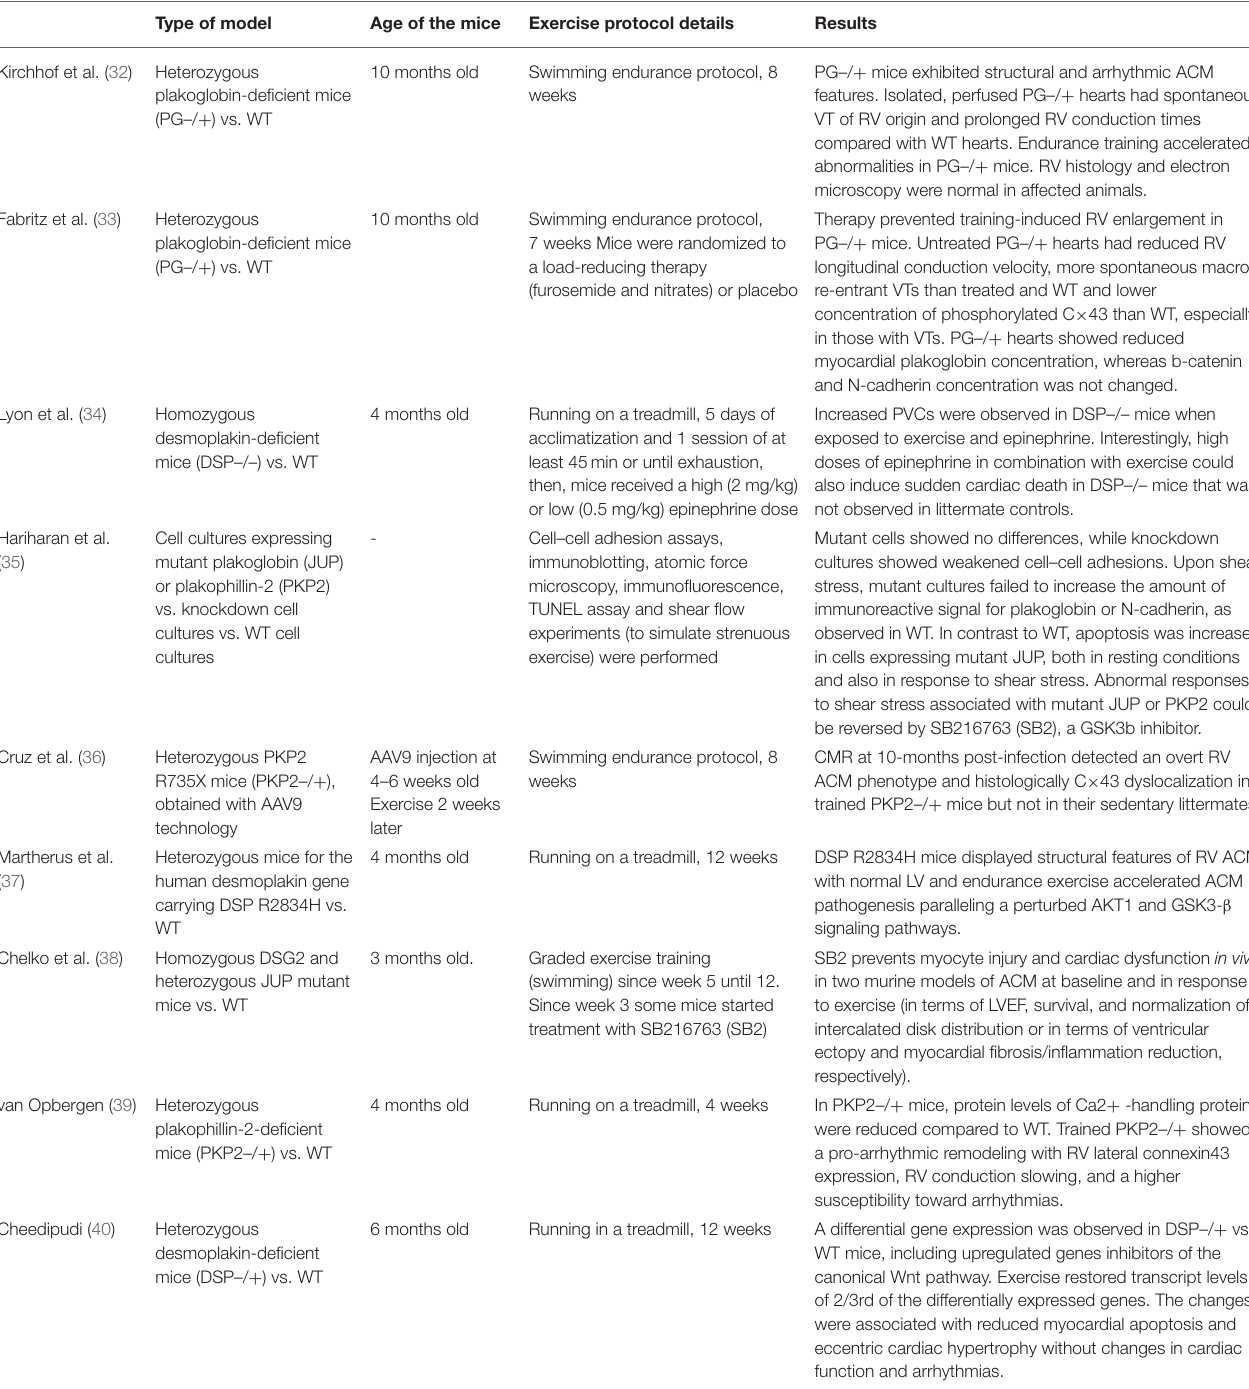
TABLE 3 | Pre-clinical ACM models to test the effect of exercise on the